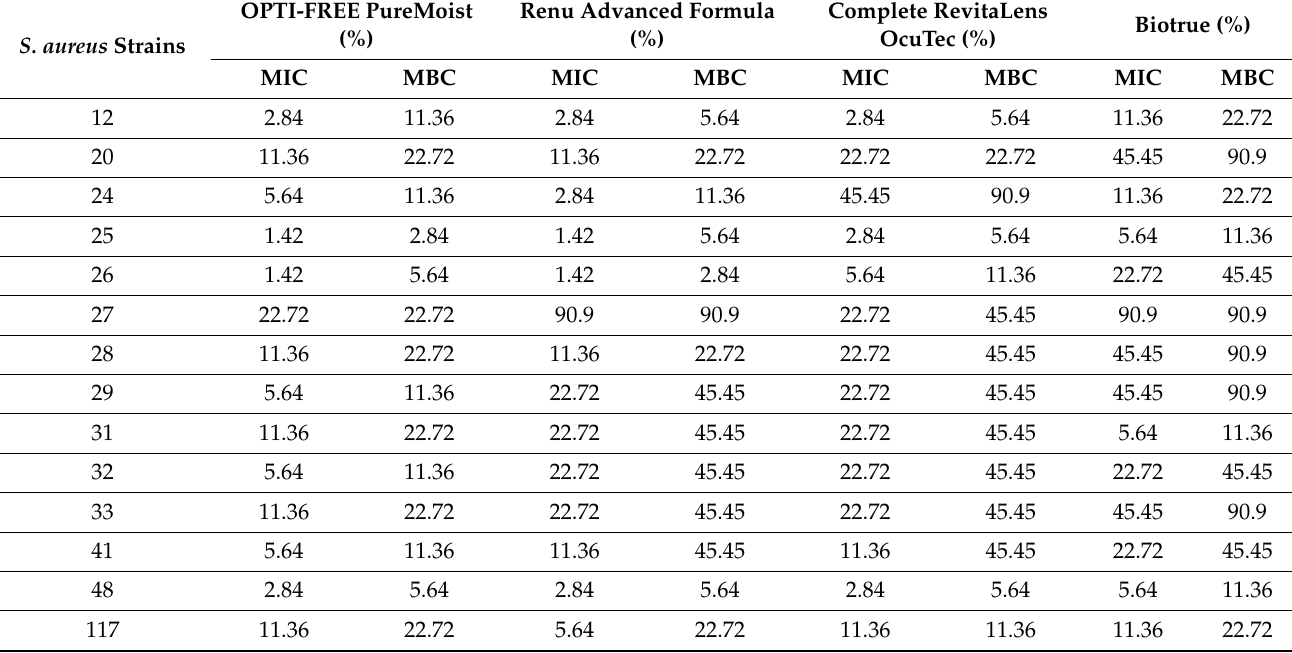
Table 2. Minimum inhibitory concentration of MPDSs for S. aureus niCIE isolates associated with contact lenses.